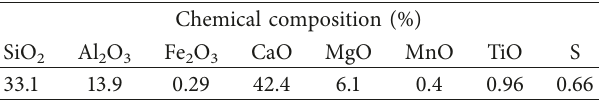
Table 2: Chemical compositions of blast furnace slag.